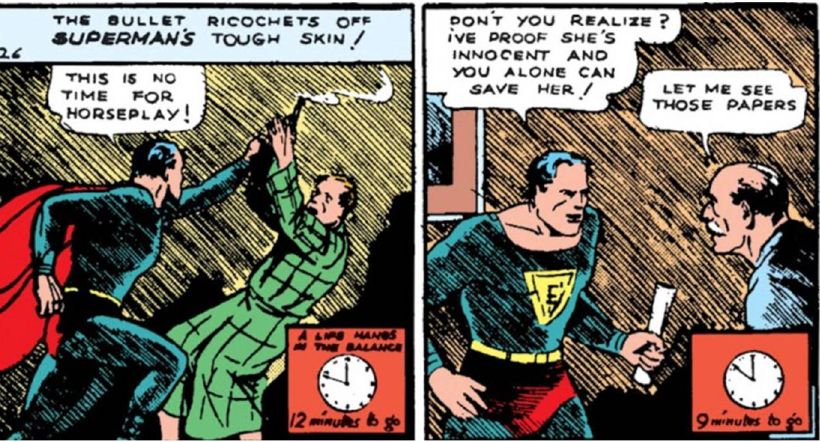
Figure 10. Joe Shuster, Superman Makes the Governor to Sign an Innocent Woman Acquittal (panels Nos. 26–27), 1938. Siegel and Shuster (June 1938), “Superman,” Action Comics #1 (Siegel and Shuster 1938a, p. 11). © DC Comics.